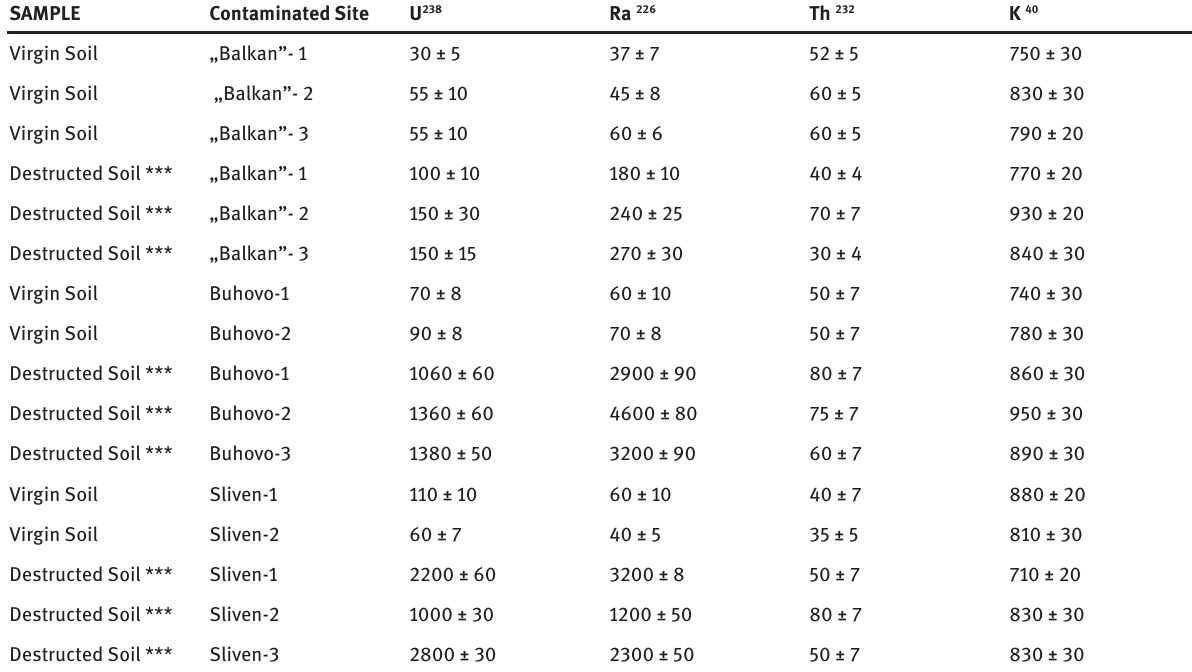
Table 1 : Activity concentrations of U 238 , Ra 226 , Th 232 and 40 K in Bq.kg -1 .